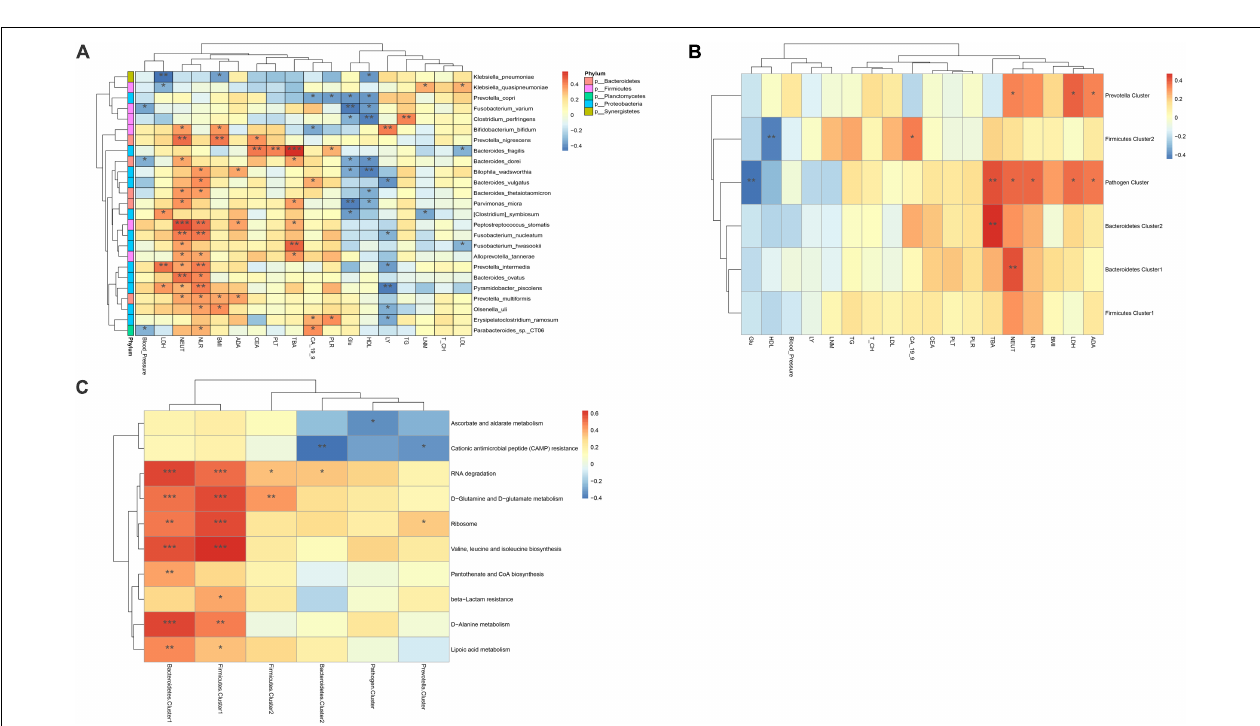
FIGURE 5 | (A) Heatmaps of interactions between species and environmental factors. Environmental factors are on the X-axis, and species are on the Y-axis. (B) Heatmap of the relationship between clusters and environmental factors. The X-axis is the environmental factor, and the Y-axis is the cluster. (C) Heatmap of the relationship between metabolic pathways and clusters. The X-axis shows the clusters, and the Y-axis shows the metabolic paths. The R-value (rank correlation) and the p -value of the corrected error finding rate were calculated. The R values are shown in different colors in the figure. The legend on the right is the color code of the different R values. * p < 0.05, ** p < 0.01, *** p < 0.001.